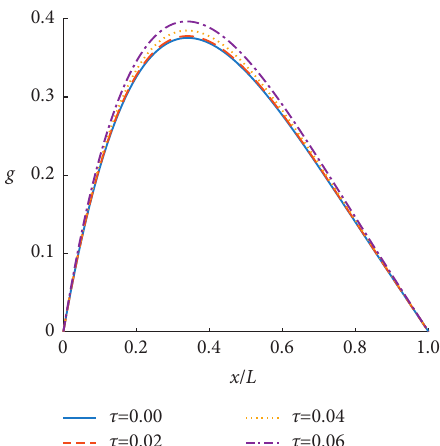
Figure 10: Influence of the nonlocal coefficient on the equivalent couple amplification factor at different locations of the